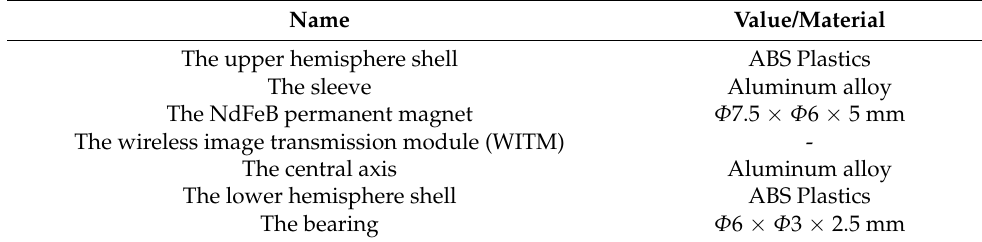
Table 1. The main structural parameters of the DSCR.